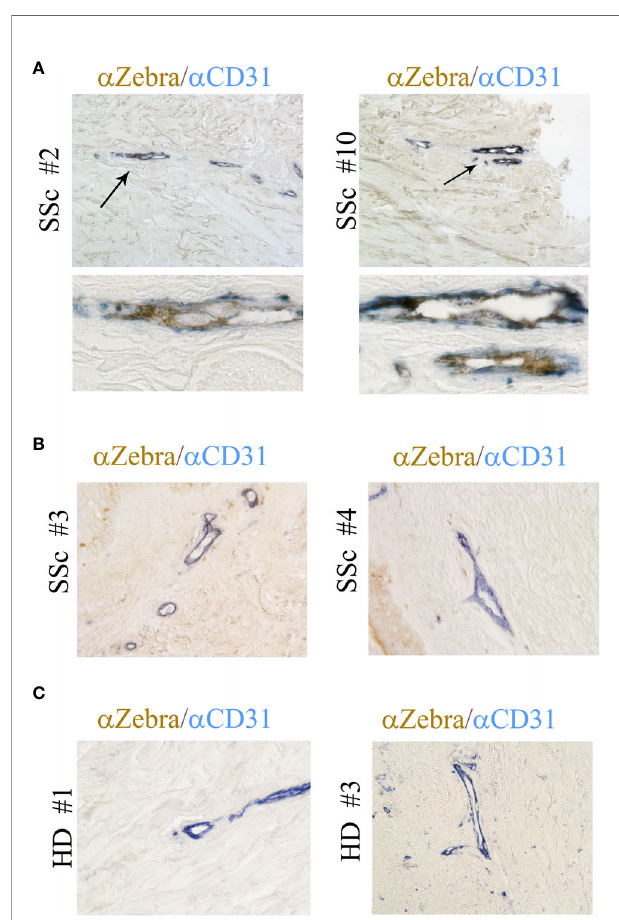
FIGURE 2 | ZTA/Zebra-EBV lytic antigen is expressed in the vessels from SSc. (A – C) Dual Immunostaining for ZTA/EBV (brown) and CD31 endothelial cell antigen (blue) in skin sections from four representatives SSc patients and two representative healthy donors. (A) Arrows indicate magni fi cation of double positive staining in SSc biopsies. Upper image original magni fi cation 100x; lower image: magni fi cation 1000x. (B, C) Original magni fi cation